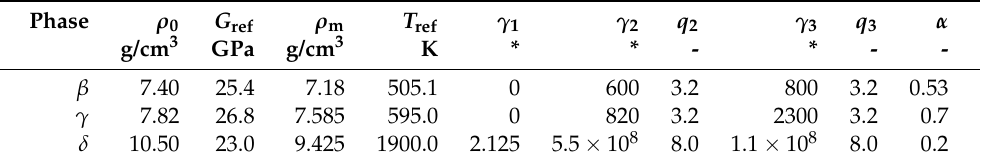
Table 1. Parameters of the BGP model for phase-specific shear modulus models. For fits with non- zero γ 1 , the exponent q 1 equals 1/3. Units of the γ values are consistent with density units (g/cm 3 ) and the corresponding q . See Equations (10)–(12) for the relevant functional